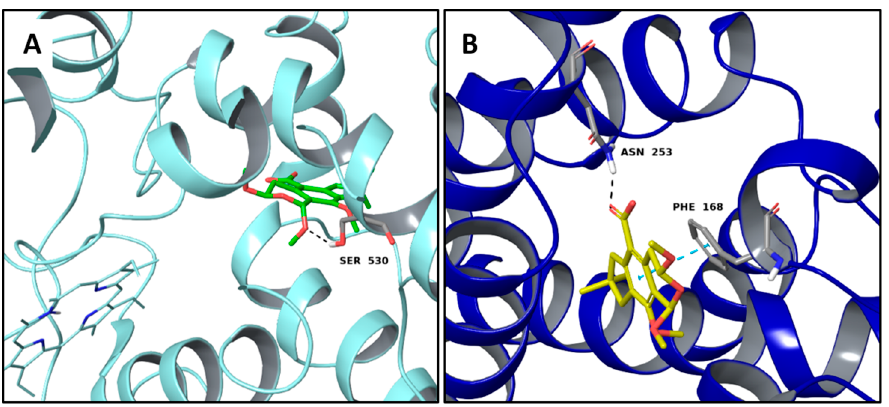
Figure 5. Molecular interactions of illudacetalic Acid and two anti-inflammatory targets: ( A ) Protein target, COX-2 (PDB: 5IKR). Protein is shown as a turquoise cartoon while ligand is shown as green carbon sticks; ( B ) Protein target, adenosine A2A receptor (PDB: 3RFM). Protein is shown as a dark blue cartoon while ligand is shown as yellow carbon sticks. H-bonds and π - π interactions are shown as dashed black and cyan lines respectively. Amino acid residues involved in the interactions are shown as gray sticks.